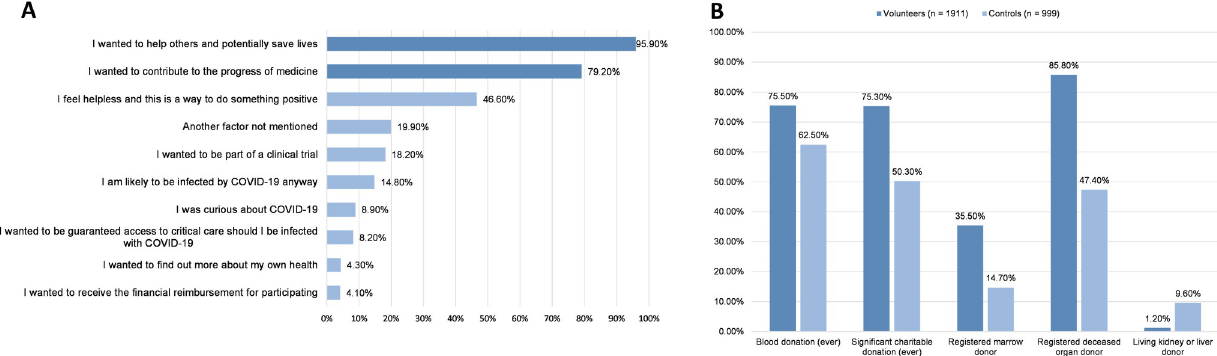
Fig 2. Volunteer group motivations for participating in human challenge studies and comparison of engagement in altruistic behaviors by volunteer vs. control group. (A) Participants in the volunteer group were asked to indicate their top three motivations for participating in a COVID-19 challenge trial from a list of ten options. Selections were not ranked, and total percentages add to 300% because each participant selected 3 options. The two most commonly selected options were “I wanted to help others and potentially save lives” (95.9%) and “I wanted to contribute to the progress of medicine” (79.2%). (B) Participants in volunteer and control groups were surveyed on their engagement with a range of altruistic behaviors, including blood donation, significant charitable donations and organ/marrow donor status. Volunteers were significantly more likely than controls to have participated in all but one of the altruistic